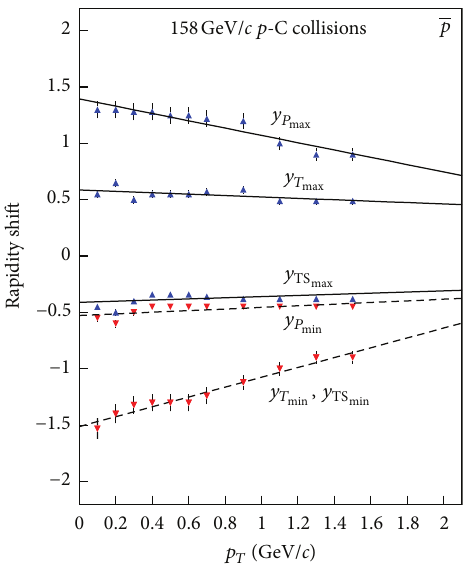
Figure 4: Correlations between the rapidity shifts and 𝑝 𝑇 . The symbols represent the parameter values used in Figures 2 and 3 due to the experimental data of the NA49 Collaboration [18], and the lines are our fitted